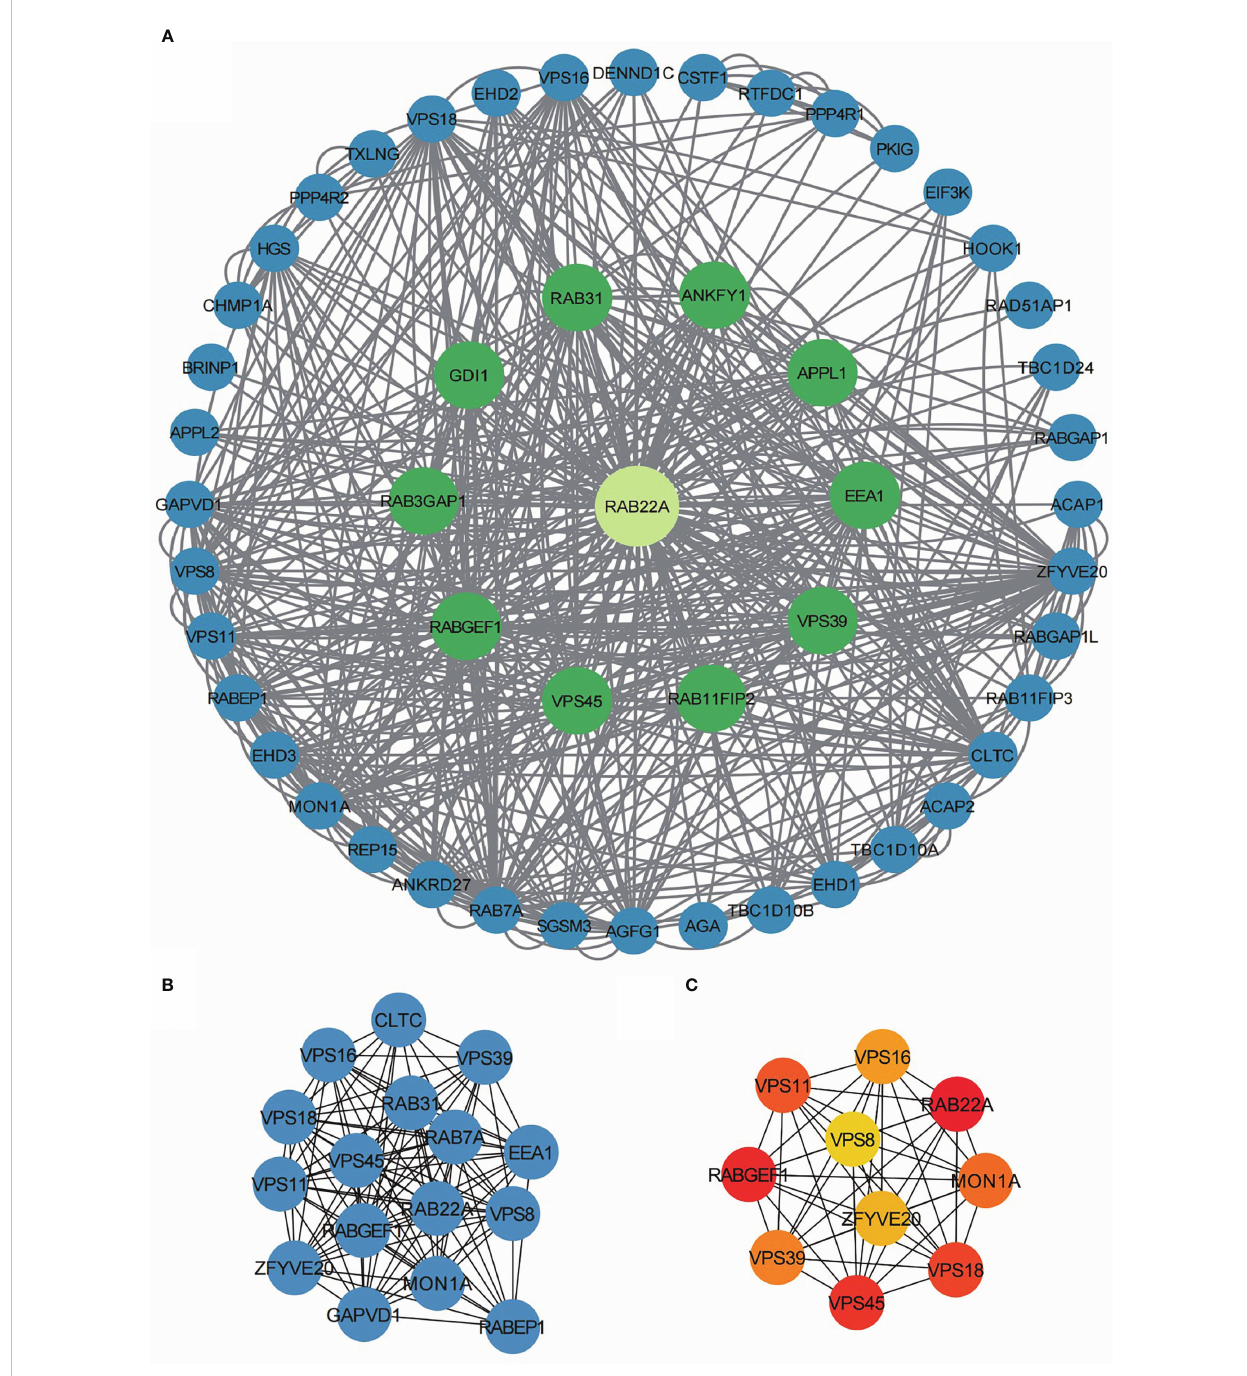
FIGURE 5 PPI network enrichment analysis. (A) The PPI network was built based on PPI pairs identi fi ed by the STRING dataset. (B) Hub gene clusters were selected from the PPI network (criteria of total scores ≥ 14,000). (C) Top 10 hub genes in the PPI